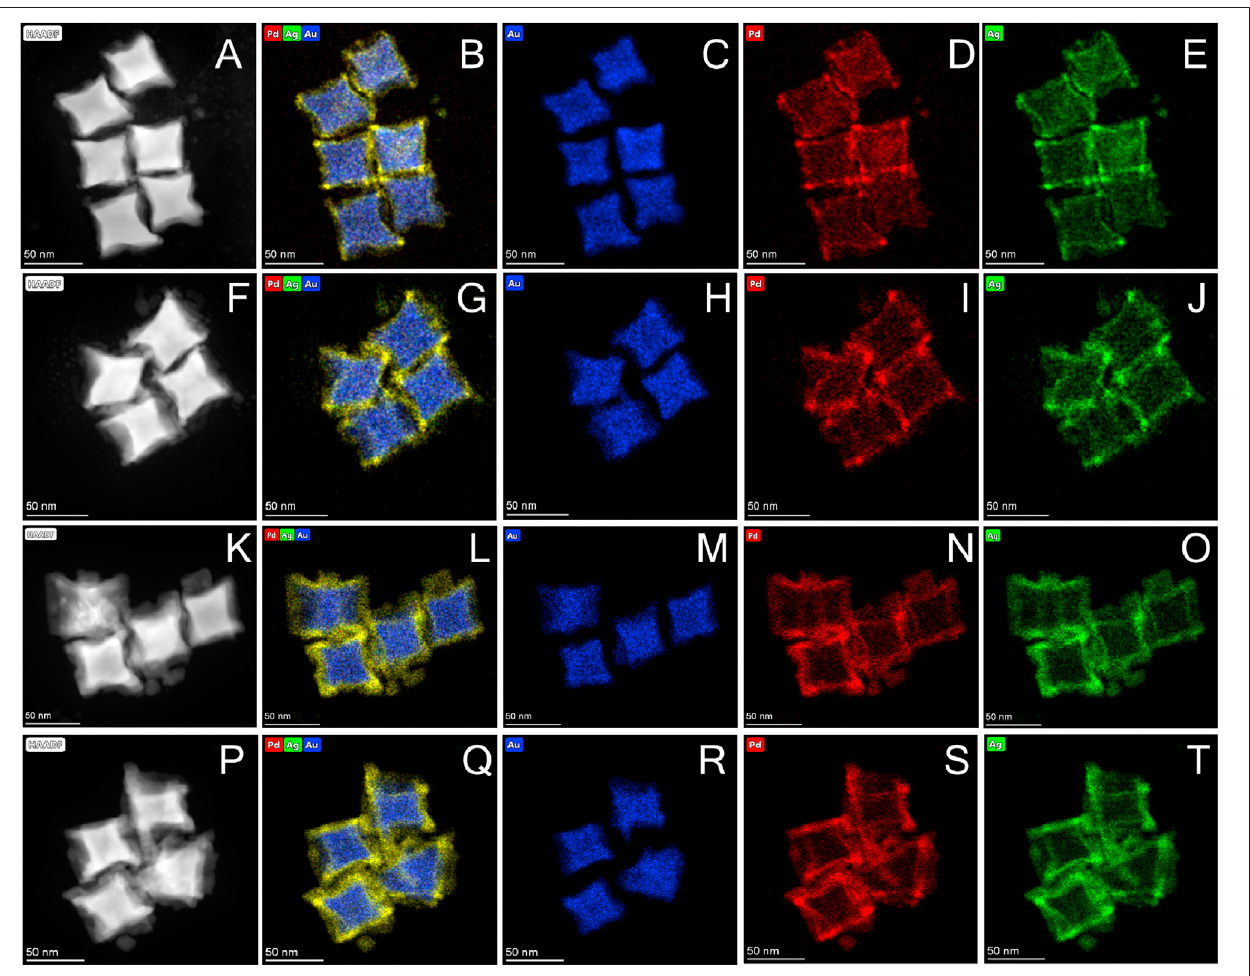
FIGURE 3 | Morphology and characterizations of Au@PdAg core-shell concave nanocubes with different thickness of PdAg shell: (A – E) 7.8 nm; (F – J) 8.8 nm; (K – O) 9.9 nm; (P – T) 12.5 nm,respectively.Theimagesin (A,F,K,andP) wereHAADF-STEMandtherestwereEDX-STEM: (B,G,L,andQ) overlapofAu,Pd,andAg, (C, H, M, and R) Au, (D, I, N, and S) Pd, (E, J, O, and T) Ag.